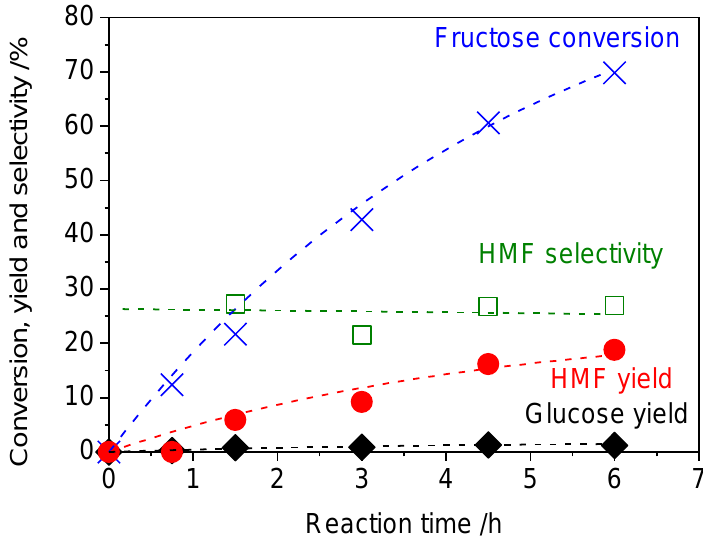
Figure 4. Time course of HMF formation from fructose over HNbWO 6 aggregated nanosheets. Reaction conditions : fructose (50 mg), catalyst (50 mg), water (3 mL), 393 K. The symbols represent the experimental results, and the curves are the calculated